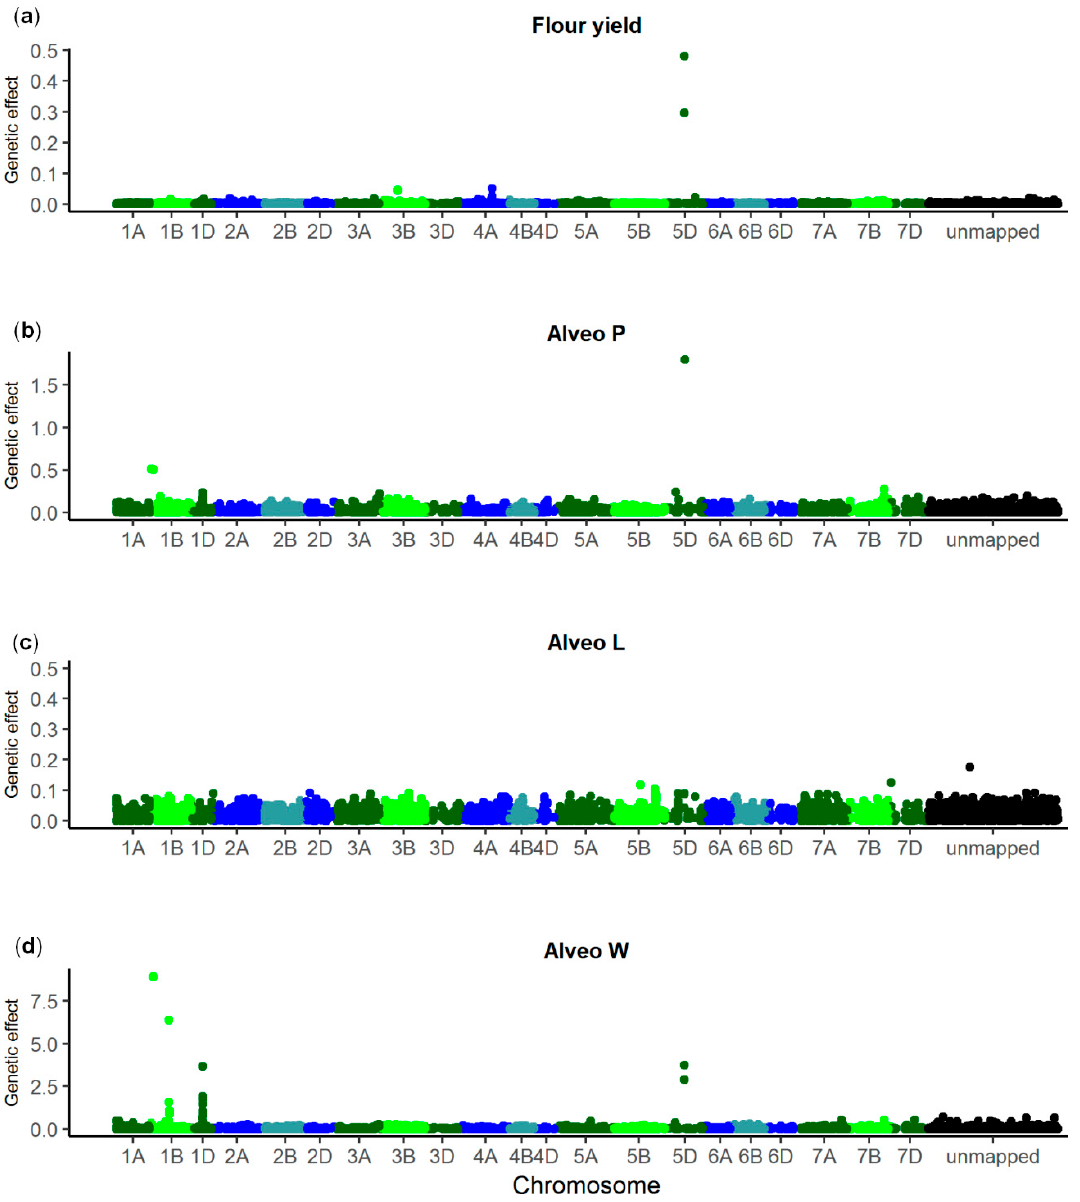
Figure 4. Genetic effect of SNPs estimated by the Bayesian Power Lasso models. ( a ): Flour yield, ( b ): Alveo P, ( c ): Alveo L, ( d ): Alveo W. Total number of SNPs: 10,802. Last bin is unmapped SNPs.